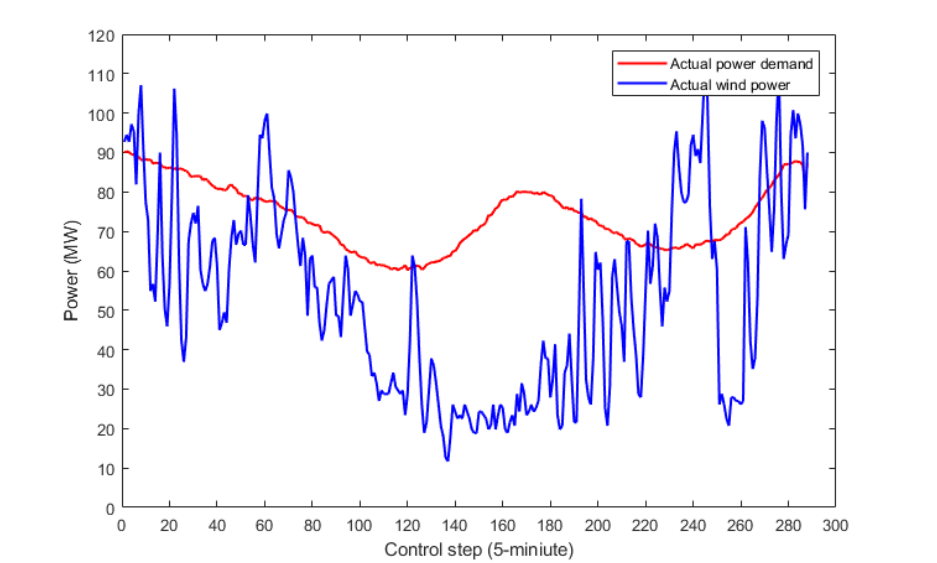
Figure 5. Actual renewable power and power demand (higher